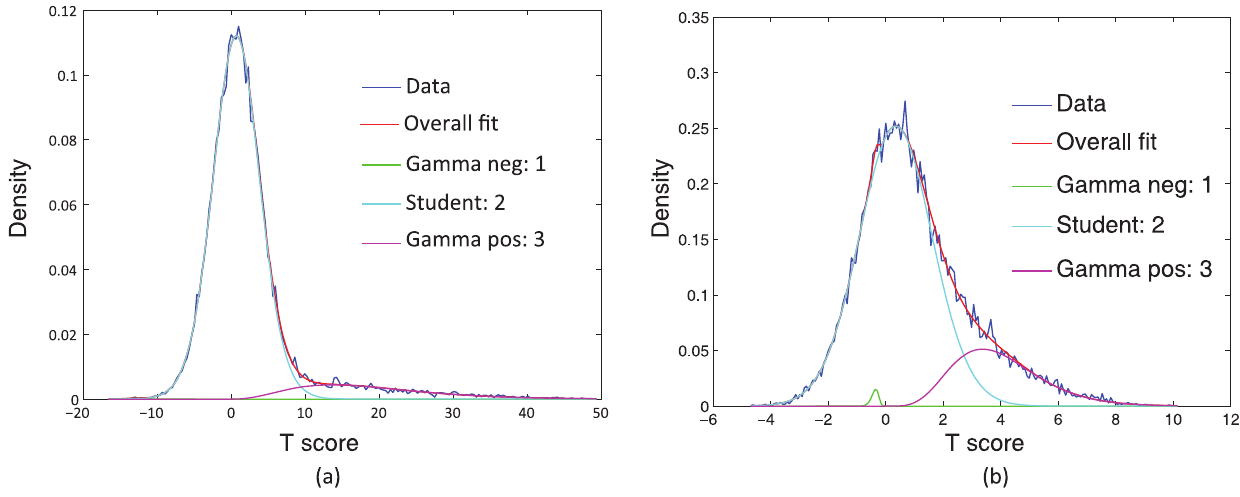
Figure 6. Examples of displaying non-Gaussian spatial structure using a Student t , Gamma pos and Gamma neg mixture model. Notice how the Gamma neg density is driven to near 0 class fraction in the absence of significant negative non-Gaussian structure.